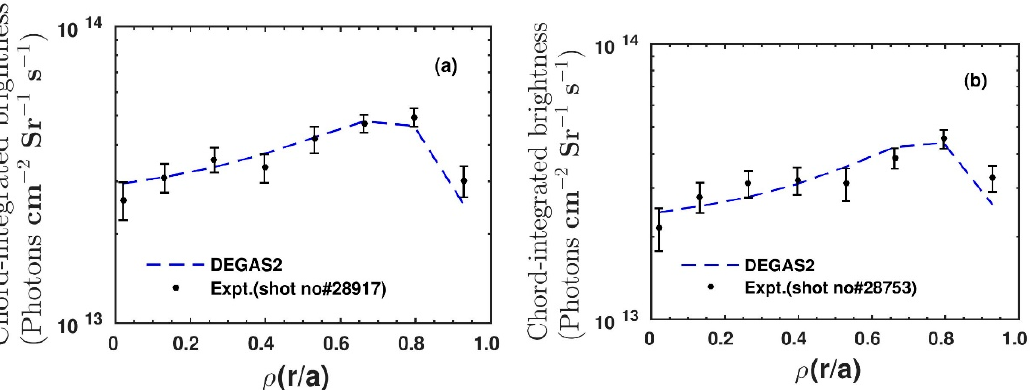
Figure 4. Simulated brightness along with the experimental measurements for shot ( a ) #28917 and ( b ) #28753.